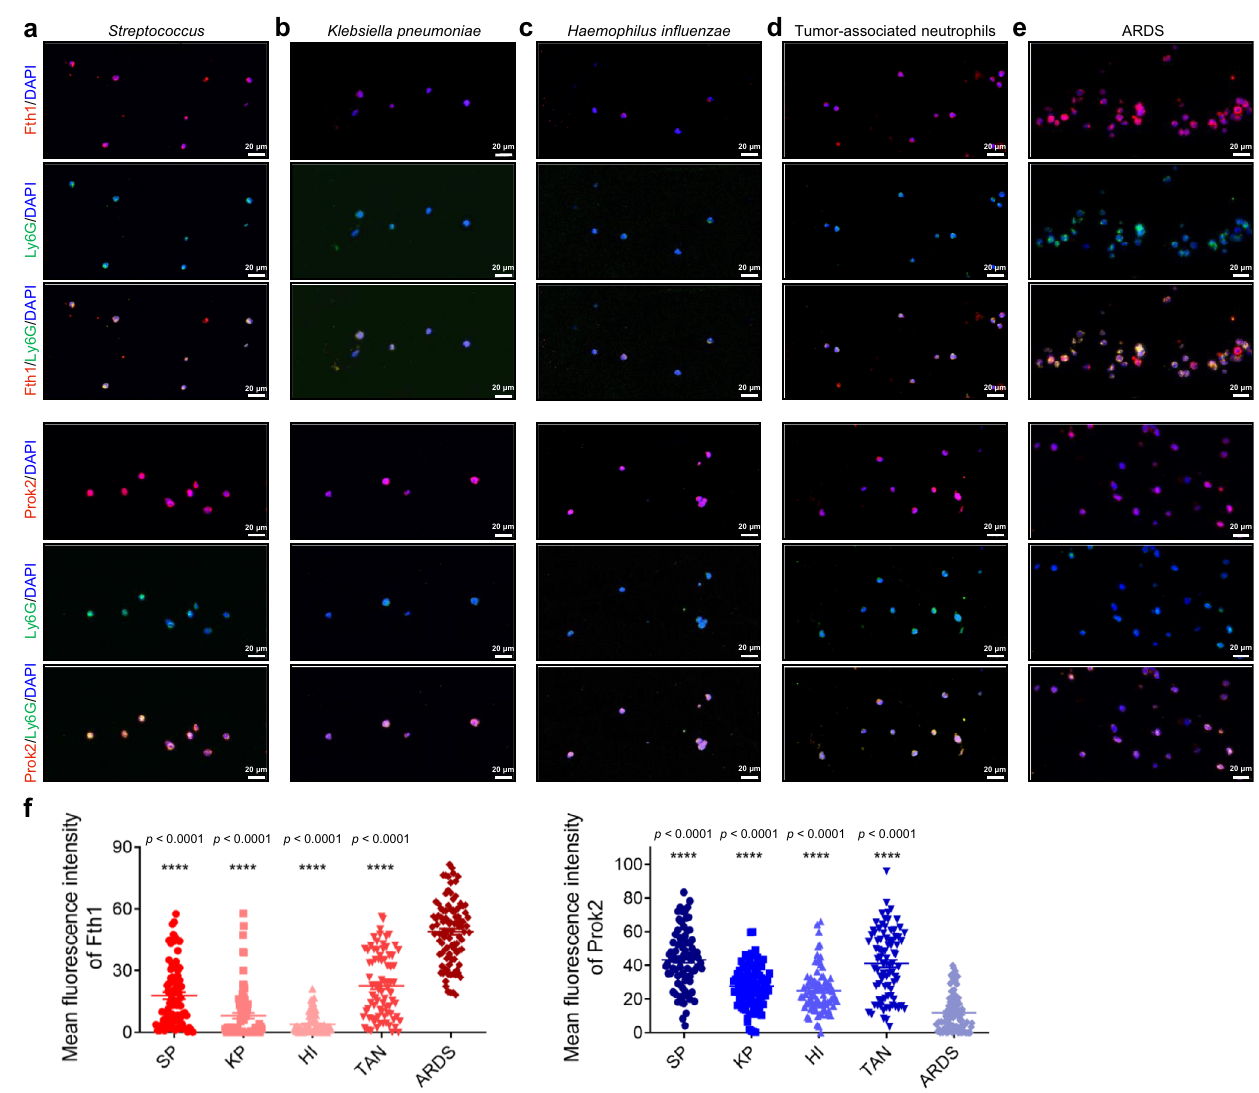
Fig. 9 | Increased Fth1 and decreased Prok2 expression in BALF neutrophils frompatientswithpulmonary infections couldprovide apotentialmarkerfor pooroutcome.a – e Representative fl uorescenceimagesofanti-Fth1/anti-Ly6Gand anti-Prok2/anti-Ly6G-stained airway neutrophils from patients infected with Streptococcus pneumoniae ( a ), Klebsiella pneumoniae ( b ) and Haemophilus in fl u- enzae ( c ), as well as patients suffering from pulmonary tumors ( d ) and ARDS ( e ). The nuclei were stained with DAPI, displayed in blue. Scale bars, 20 µ m. ( f ) Quan- ti fi cation of the fl uorescence intensity in each neutrophil showing the level of Fth1 ( n =81 from 3 patients, 81 from 4 patients, 81 from 3 patients, 81 from 3 patients,